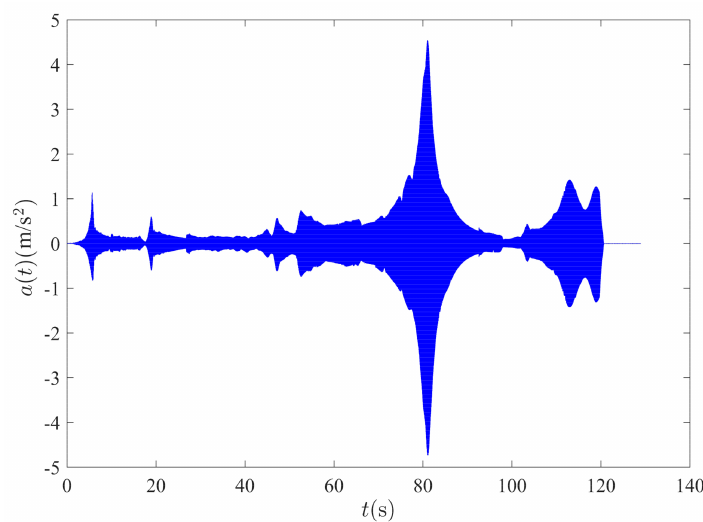
Figure 9. Time-domain signal of wind turbine blade extracted from a 4 sensor of test #K.